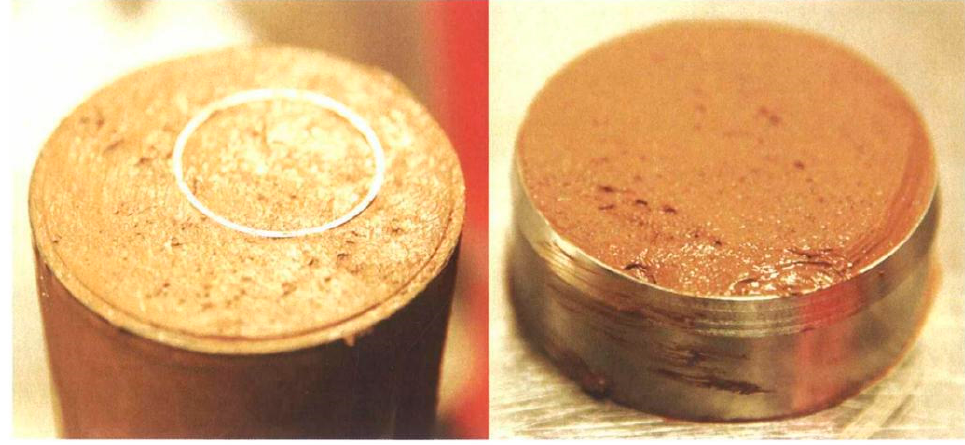
Figure 7. Photographic images of the deep-sea sediment samples.